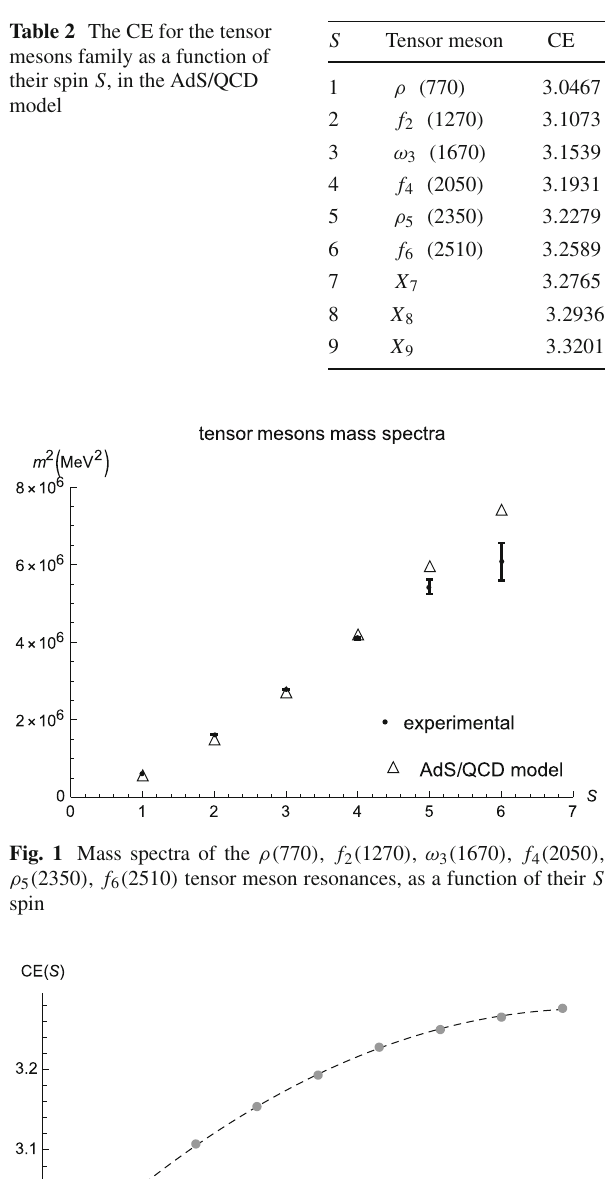
A second type of configurational-entropic Regge trajec- tory, relating the CE to the tensor meson family (squared) mass spectra, is shown in Fig. 3, strictly for the tensor meson resonances in [49], corresponding to S ≤ 6. The dashed curves in Figs. 2 and 3 correspond, respec- tively, to Eqs. (15) and (16). For the plot in Fig. 3, the configurational-entropic Regge trajectory has the